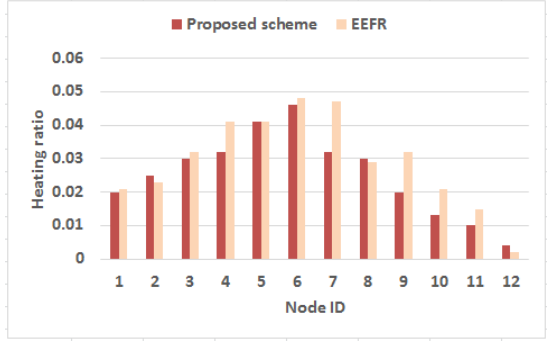
Figure 11. Heating ratio of each node in the network.